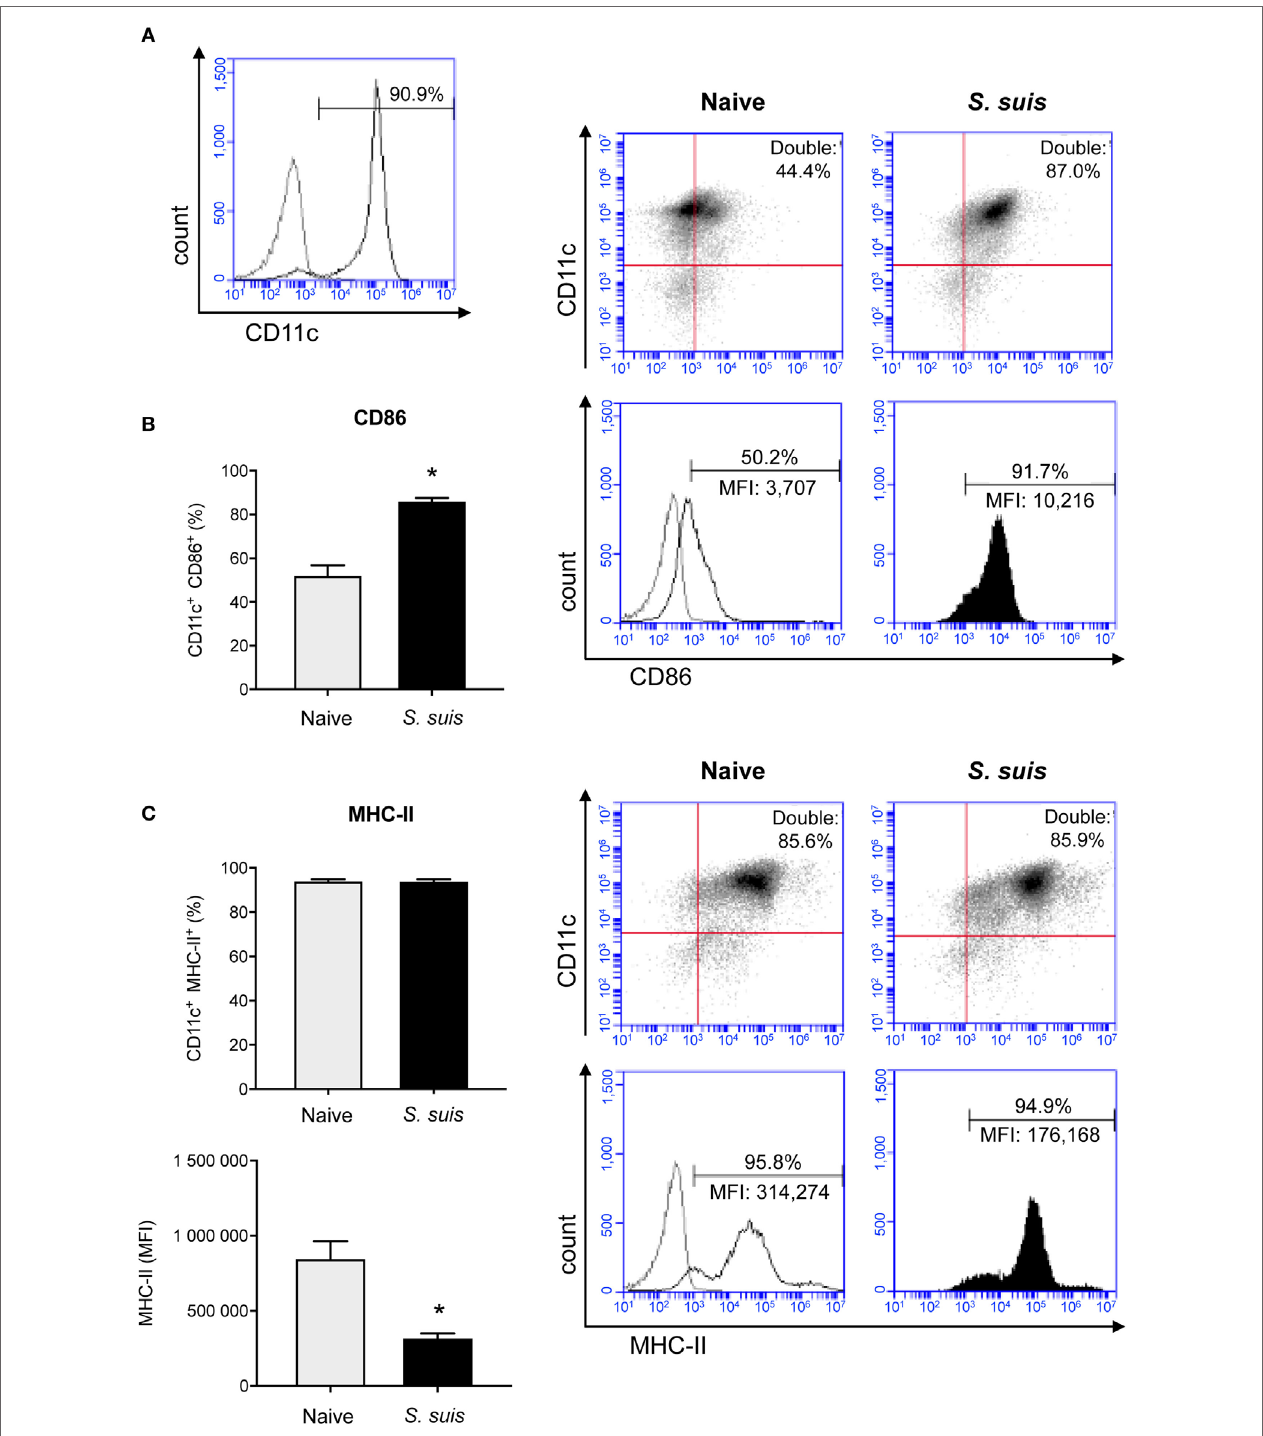
FigUre 2 | Splenic dendritic cells (DCs) become phenotypically mature but show a reduction in their MHC-II expression levels during Streptococcus suis in vivo infection . C57BL/6 mice were injected intraperitoneally with 5 × 10 7 CFU of S. suis wild-type (WT) strain P1/7. Spleens from mock-infected (naïve) and infected mice were harvested 6 h after infection ( n = 2–3 per group × 2 independent experiments). Splenic DCs were purified by MACS positive selection and cells were surface stained for FACS analysis. CD11c purity is shown in (a) . The expression of (B) CD86 and (c) MHC-II was evaluated. Data are expressed as mean ± SEM (of % double positive cells or of mean fluorescence intensity (MFI). In the latter case, events are gated on CD11c + cells). Representative dot plots and histograms have been selected for this figure. The gray lines on the histograms are isotype controls. 30,000 events were acquired per sample and data analysis was performed using BD Accuri ™ C6 software. Quadrants were drawn based on PE/Cy5- and PE-control stains and plotted on logarithmic scales. *P < 0.05 indicates a statistically significant difference compared to naïve